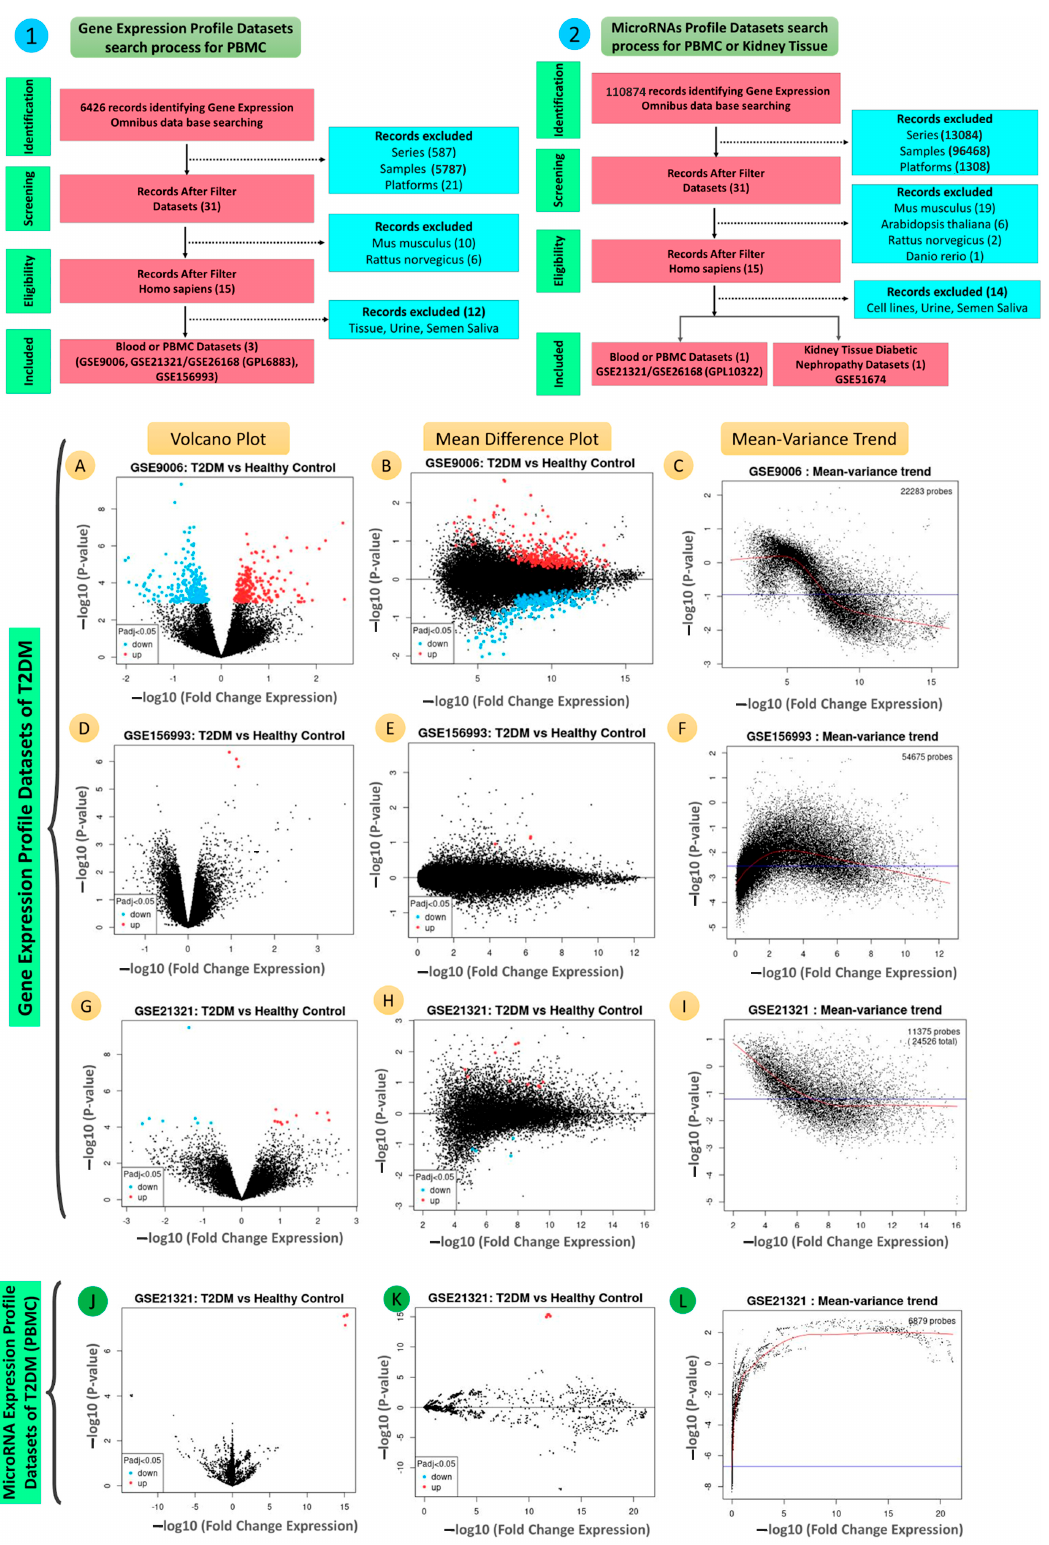
Figure 1. The flow diagram illustrates the process of ( 1 ) the gene expression profile datasets and ( 2 ) the microRNAs expression profile datasets collections and shows the number of datasets considered for inclusion. ( A , D , G , J ) volcano plots; ( B , E , H , K ) mean difference plots; ( C , F , I , L ) mean–variance trends showing the DEGs in all four datasets, GSE9006, GSE156993, GSE21321/GSE26168 (GPL6883), and GSE21321/GSE26168 (GPL10322), for blood of T2DM.